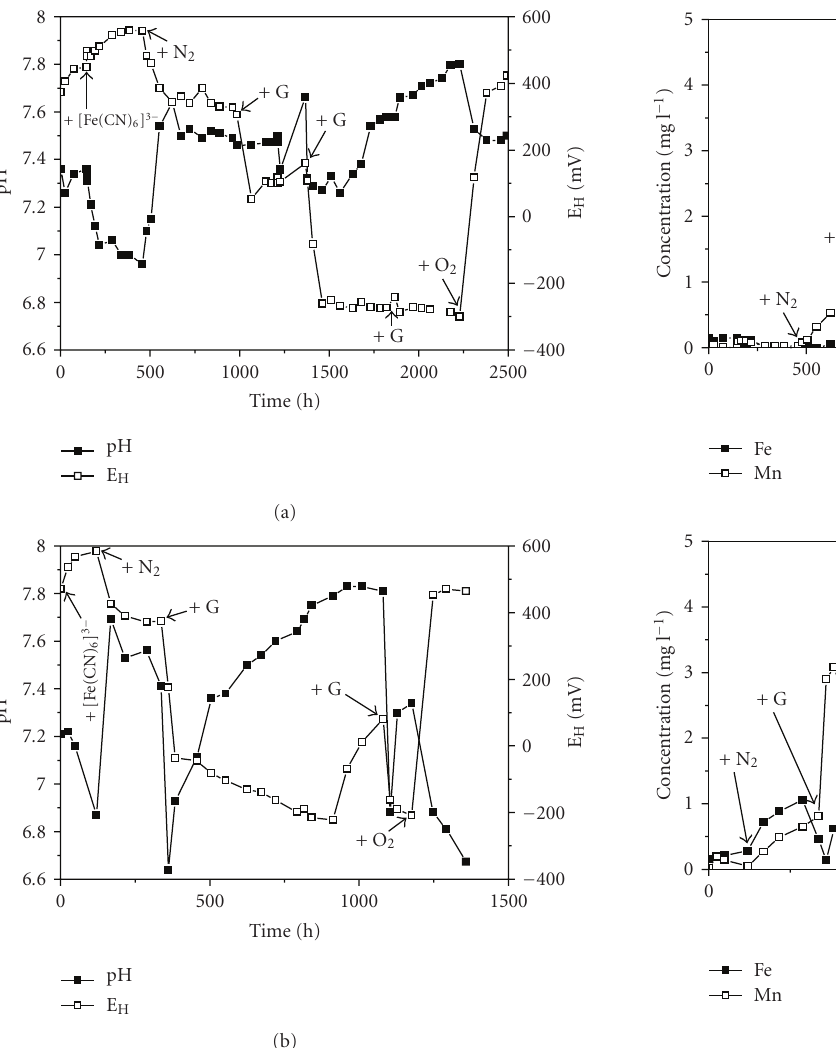
Figure 3: Fe and Mn concentrations during the microcosm Figure 2: Redox potentials and pH during the microcosm experi- experiments (a) no. 1 and (b) no. 2. “+ G” denotes additions of ] 3 − ” denotes addition of ments (a) no. 1 and (b) no. 2. “+[Fe(CN) 6 glucose, “+ N 2 ” and “+ O 2 ” denote the gas purged through the ferricyanide, “+ G” denotes additions of glucose, “+ N 2 ” and “+ O 2 ” denote the gas purged through the suspensions.